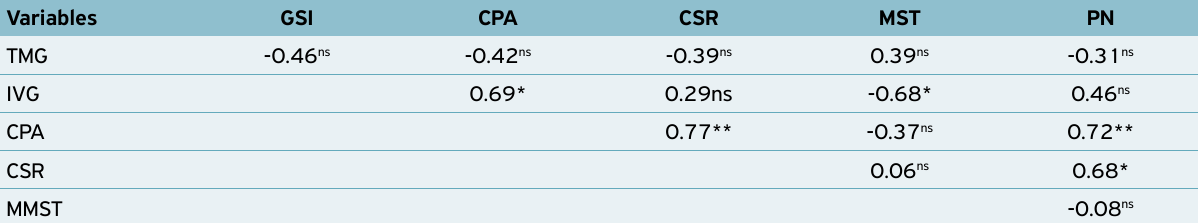
Table 4. Pearson’s linear correlation matrix among evaluated variables, constructed with the aid of the Statistical Analysis System software, Cruz das Almas, BA, 2013.